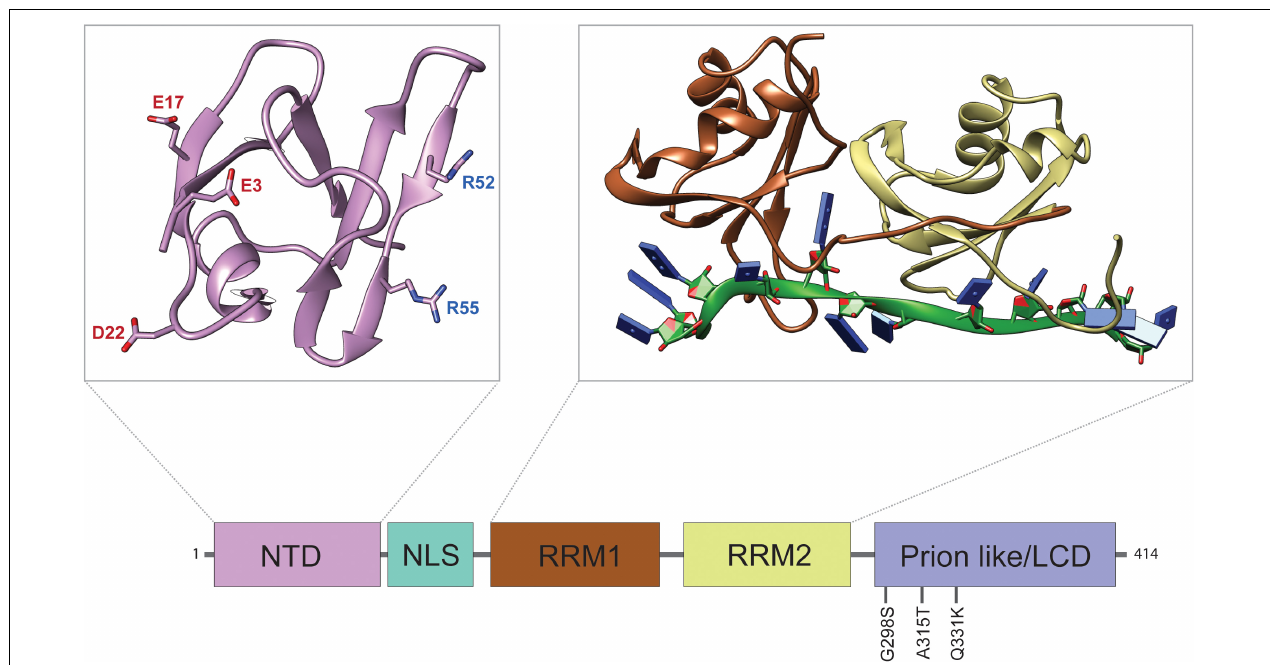
FIGURE 1 | Structure and Domain Features of TDP-43. Domain map of TDP-43 depicting the approximate sizes of functional domains. The disease-associated mutations discussed in this review are highlighted. From left to right: N-terminal domain (NTD), nuclear localization signal (NLS), RNA-recognition motif 1 (RRM1), RNA-recognition motif 2 (RRM2), and low complexity domain (LCD). Top left panel: structure of the NTD (PDB ID: 5MDI) with aggregation antagonizing amino acid residues E3, E17, D22, R52, and R55, as indicated (Afroz et al., 2017). The negatively charged NTD residues (red) form salt bridges with positively charged residues (blue) of other TDP-43 NTDs to form oligomers. Top right panel: structure of the tandem RRMs bound to UG-rich RNA (PDB ID: 4BS2) (Lukavsky et al., 2013). The RNA-structure is shown in green with nucleobases represented by blue